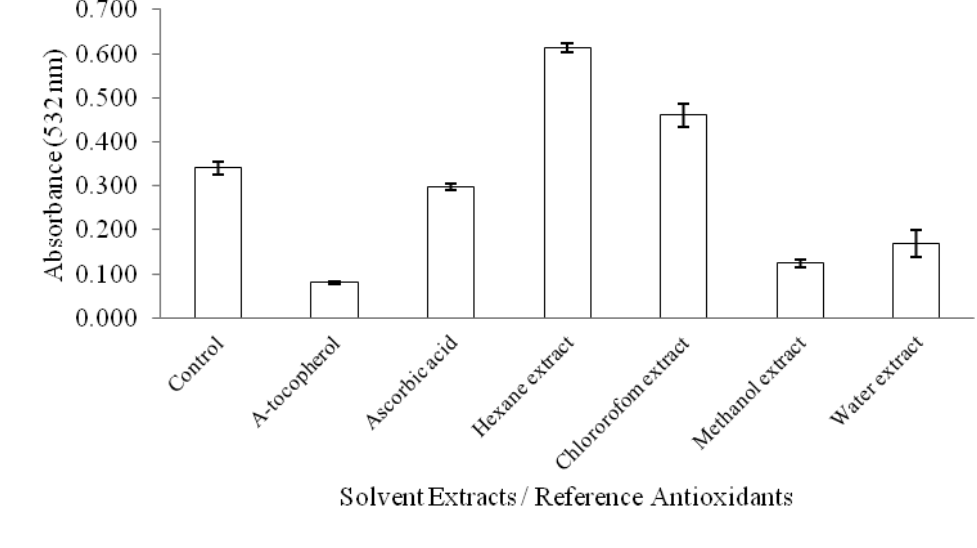
Figure 2. Thiobarbituric acid reactive substances measured for kenaf seed extracts fractionated in different